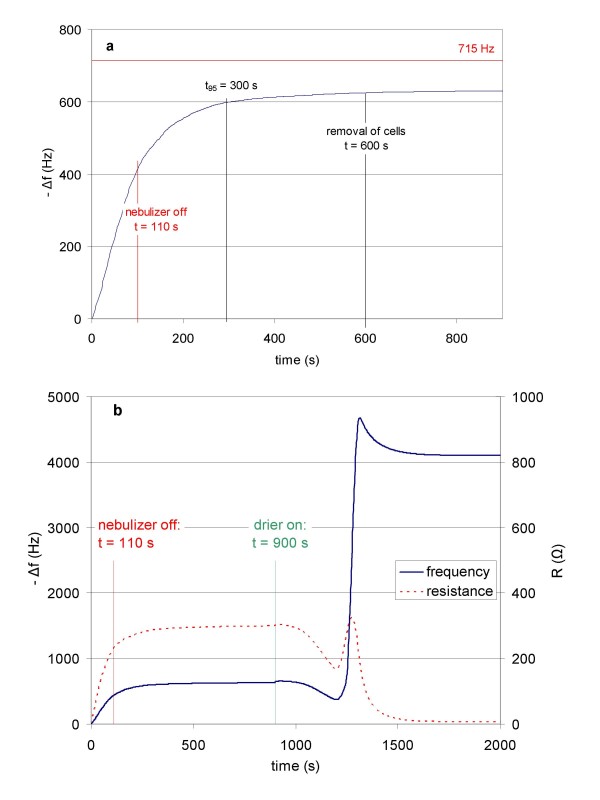
Response of the quartz crystal microbalance (QCM) during a typical ALICE exposure. a) Within 2 s of the nebulizer being turned on (t = 0) -Δf increases due to droplet deposition on the quartz crystal. At 110 s, the nebulizer is completely discharged (here: 1 mL of 6% (NH4)2SO4 solution) and the air flow is stopped. Subsequently, single particle sedimentation depletes the stagnant cloud and at 300 s, 95% of the final -Δf value (630 Hz) is reached (end of droplet deposition), which is still well below 715 Hz, the saturation value of the QCM for an infinitely thick water layer. During typical ALICE experiments, the cells were removed at 600 s (here no cells were in the ALICE). b) At 900 s dry filtered air is introduced in the exposure chamber, which dries the liquid film on the QCM. At 1500 s, the QCM deposit has completely dried, as indicated by the resistance (R) approaching 0 Ω. The dry salt mass of 72.4 μg/cm2 can then be obtained from -Δf = 4100 Hz using equation 3. For optimized timing (~10 min per exposure run) the cells could be removed from the ALICE after 300 s (5 min) and the QCM deposit can be dried more efficiently (within a few minutes) by removing the QCM from the exposure chamber and drying it with dry air.